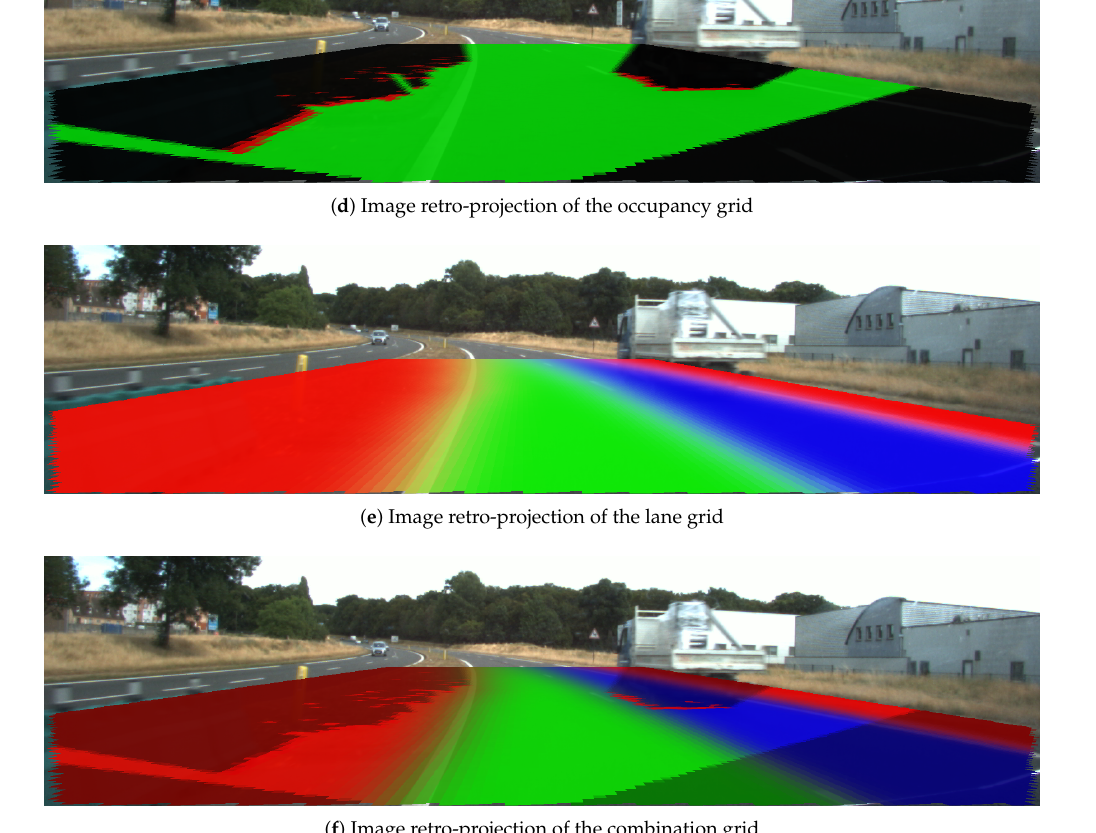
Figure 19. Result scene two. Same color code as in Figure